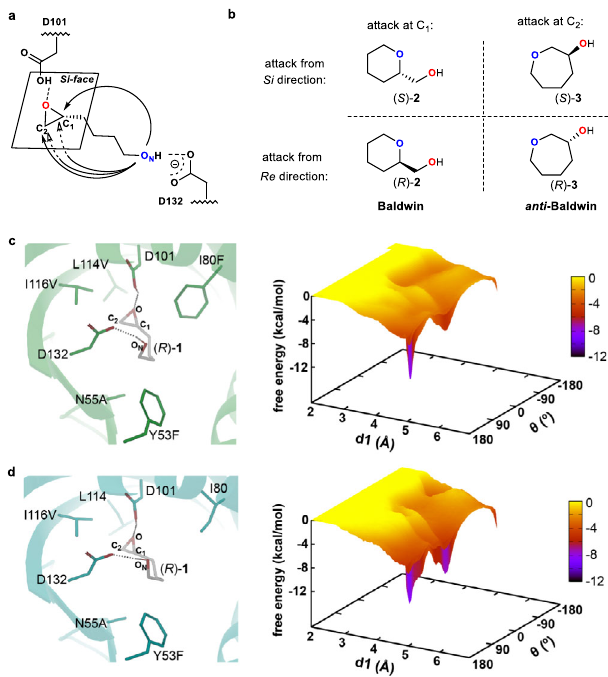
Fig. 6 | Computational analysis of the designed mutants SZ612 and SZ616. a Proposed mechanism of LEH-catalyzed cyclization of the model substrate ( R )- 1 . b Schematicrepresentationofthefourpossibleproducts. c ModelSZ612 ‒ ( R )- 1 and its free energy landscapes (kcal/mol) as a function of the dihedral angle θ (O N -C1- C2-O). d ModelSZ616 ‒ ( R )- 1 and its free energy landscapes (kcal/mol)asa function of the dihedral angle θ (O N